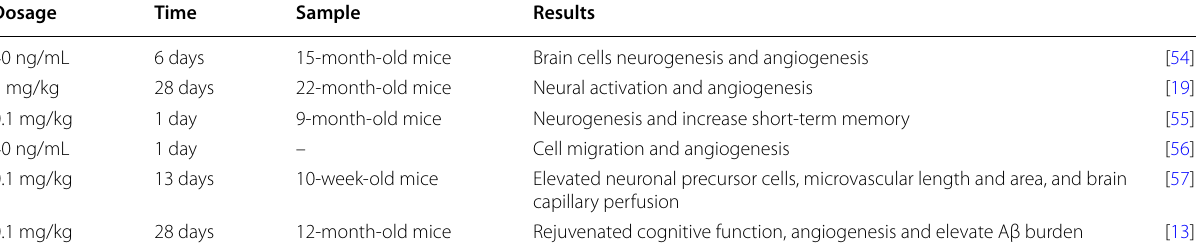
Table 1 In vivo studies of GDF11